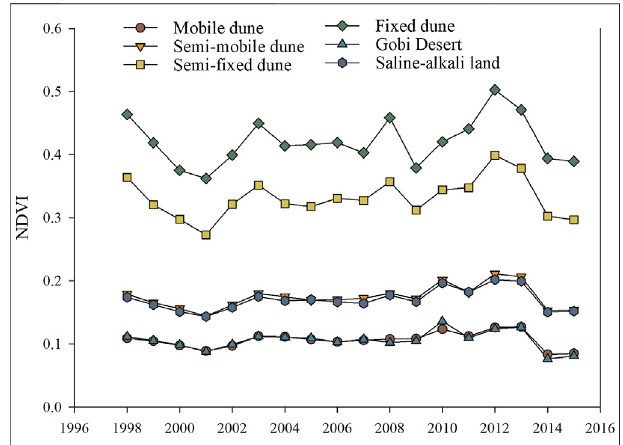
FIGURE 3 | The inter-annual variations of the normalized-difference vegetation index (NDVI) for the six desert types.